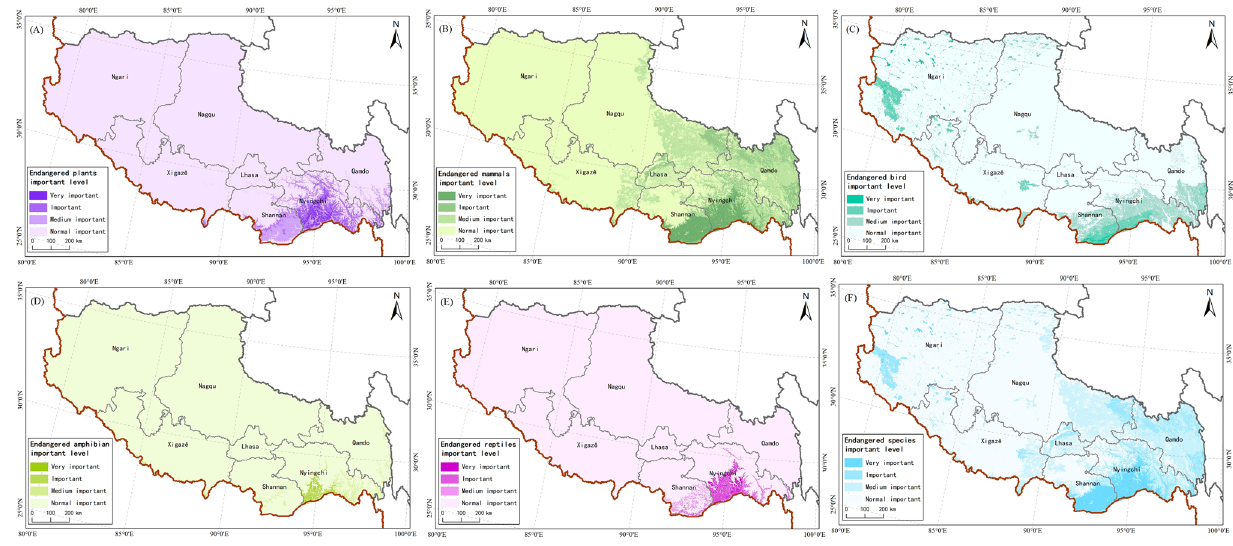
Figure 2. Spatial pattern of Biodiversity importance of China’s Tibet autonomous region, ( A ) distribution of the importance of endangered plants, ( B ) distribution of importance of endangered mammals, ( C ) distribution of importance of endangered birds, ( D ) distribution of importance of endangered amphibians, ( E ) distribution of importance of endangered reptiles, ( F ) distribution of importance of endangered species. We created this figure in using ArcGIS 10.5 for maps (URL: http:// www. esri. com/).